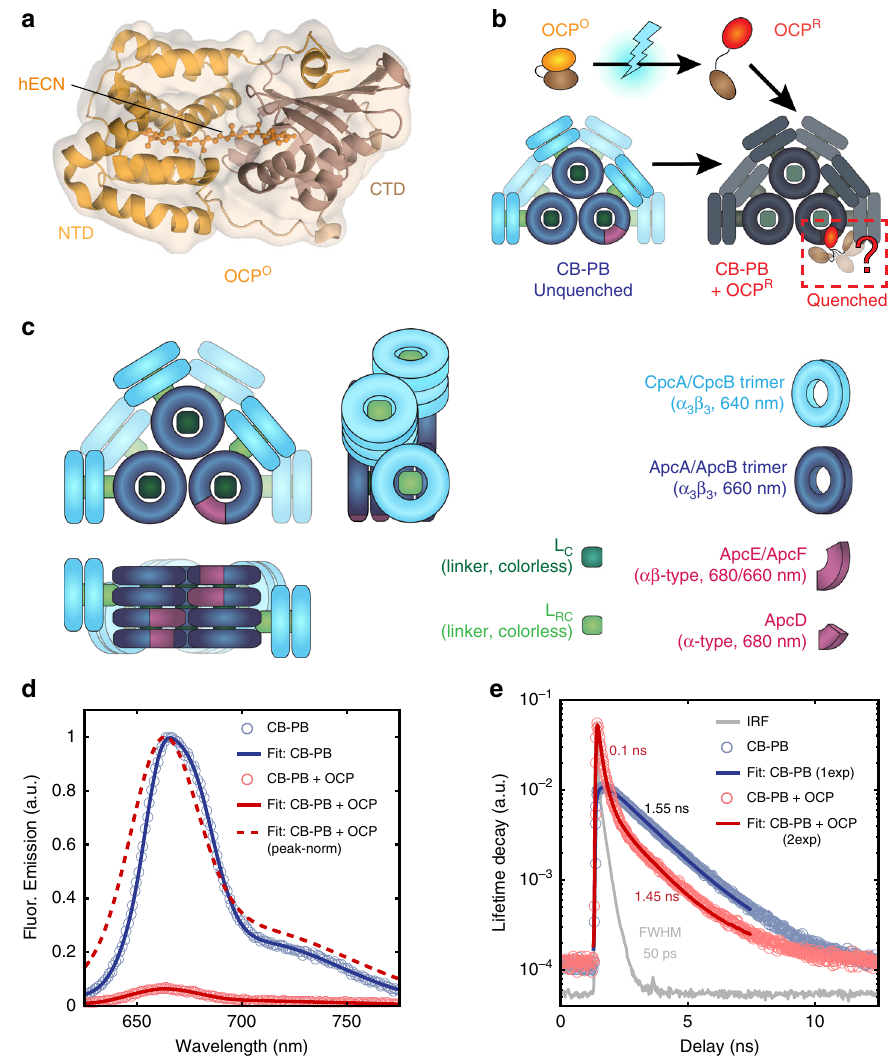
Fig. 1 OCP quenches fl uorescence in the phycobilisome. a Structure of OCP in inactive orange form, from PDB 3MG1 42 . A keto-carotenoid spans the interior of the N- and C-terminal domains (NTD and CTD, respectively), which are connected with a fl exible linker and separate upon photoactivation. b Schematic of OCP activation. Upon absorption of blue-green light, OCP O is converted to OCP R , which binds to and quenches an unknown location on the core of the phycobilisome (PB). c Structure of the truncated PB mutant used in this study (CB-PB from Synechocystis PCC 6803 51 ). Disc-shaped trimers of phycobiliproteins are joined by linker proteins into stacks that make up the core and rods of the PB. d Bulk fl uorescence emission spectrum of PB in the absence (navy) and presence (maroon) of bound OCP R . Solid lines: area-normalized for total relative fl uorescence intensity. Dotted line: peak-normalized. e Bulk lifetime decays for PB in the absence (light blue) and presence (light red) of bound OCP R . Single- and double-exponential fi ts are shown in navy and maroon, respectively. Gray: instrument response function, FWHM 50